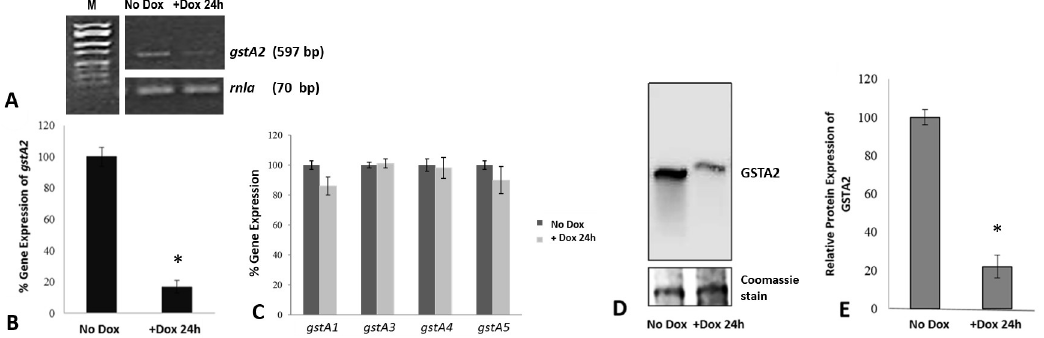
Fig 7. Analysis of gstA2 expression in RNAi- gstA2 knockdown cells. Semi-quantitative PCR analysis of 24h doxycycline-induced RNAi-specific knockdown gstA2 gene expression showed ~82% decrease in expression of gstA2 (A, B), other gstAs expression were not significantly altered (C); normalized to rnla internal standard. M, molecular weight markers (50–2000 bp); rnla (70 bp). Western blot analysis of these cells with a rabbit anti-DdGSTA2 polyclonal antibody indicated ~80% decrease in GSTA2 protein (D,